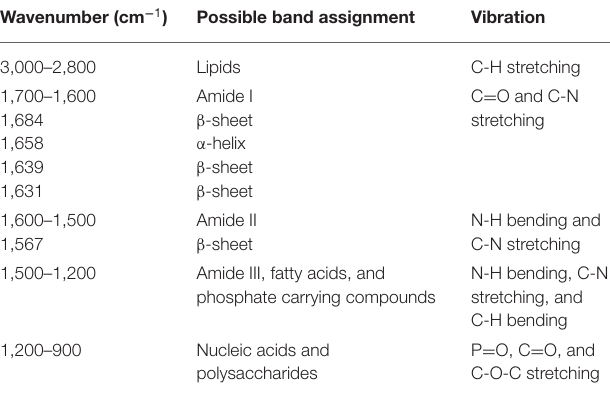
TABLE 1 | Vibrational regions and possible band